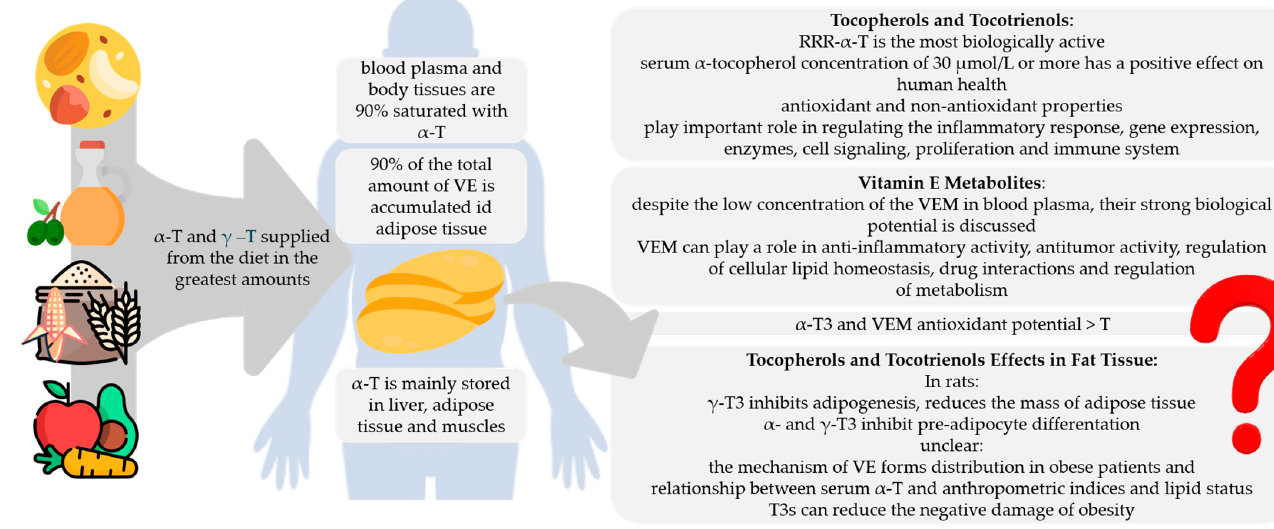
Figure 3. Summary of potential health benefits of tocopherols and tocotrienols. T, tocopherol; T3, tocotrienol; VE, vitamin E; VEM, vitamin E metabolites. The author’s own study based on [4,8,10–12,35–37,74,99,104–107,112–114]; icons source: www.flaticon.com (accessed on 31 March